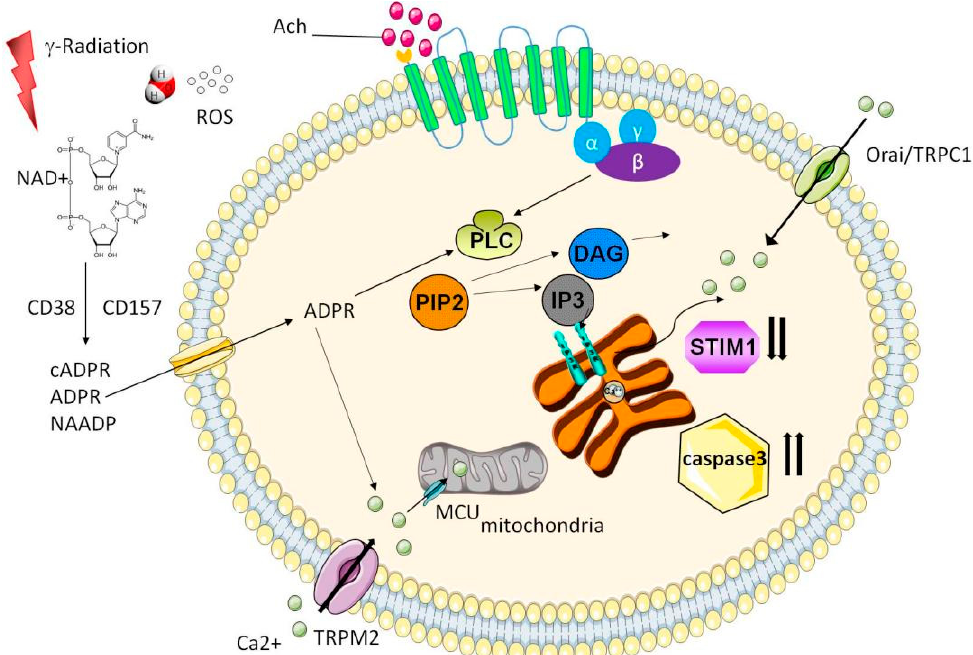
Figure 1. Calcium signal mechanism of radiation-induced salivary gland injury. Acetylcholine acts on G-protein-coupled receptors and activates the G-protein effector PLC by activating the G protein so that PIP2 is decomposed into IP3 and DAG. IP3 acts on the IP3 receptor on the endoplasmic reticulum, and then intracellular Ca 2+ is released and the intracytoplasmic Ca 2+ concentration increases. As the second messenger, Ca 2+ increases [Ca 2+ i] through Ca 2+ sensor protein STIM1, which regulates the SOCE. This process is controlled by the channels TRPC1 and Orai1. When exposed to a muscarinic acetylcholine receptor agonist, the irradiated salivary gland cells isolated from the body are impaired in their ability to mobilize [Ca 2+ i] after irradiation. NAD+ and ROS accumulate during inflammation and tissue damage. External NAD+ may be converted to ADPR, cADPR, and nicotinic acid adenine dinucleotide phosphate by the ectoenzymes CD38 and CD157. Extracellular ADPR may then bind to plasma membrane receptors, increase [Ca 2+ i] through the release of Ca 2+ from stores via G-proteins, and activate PLC with subsequent IP3 production. H 2 O 2 may also cross the plasma membrane and mobilize ADPR from mitochondria (both H 2 O 2 and cADPR can synergize with ADPR to activate TRPM2). Free cytosolic ADPR will act on the plasma membrane TRPM2 channels, enabling Ca 2+ influx across the plasma membrane and/or the release of lysosomal Ca 2+